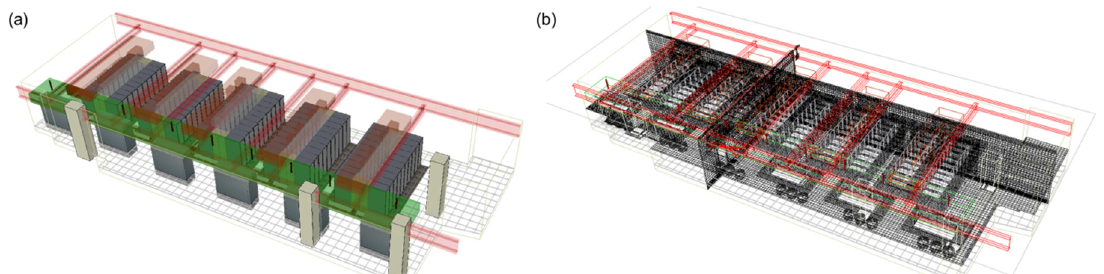
Figure 2. CFD modeling; (a) 3D solution domain and (b) unstructured Cartesian grid. Table 1. Boundary conditions of CFD simulation.